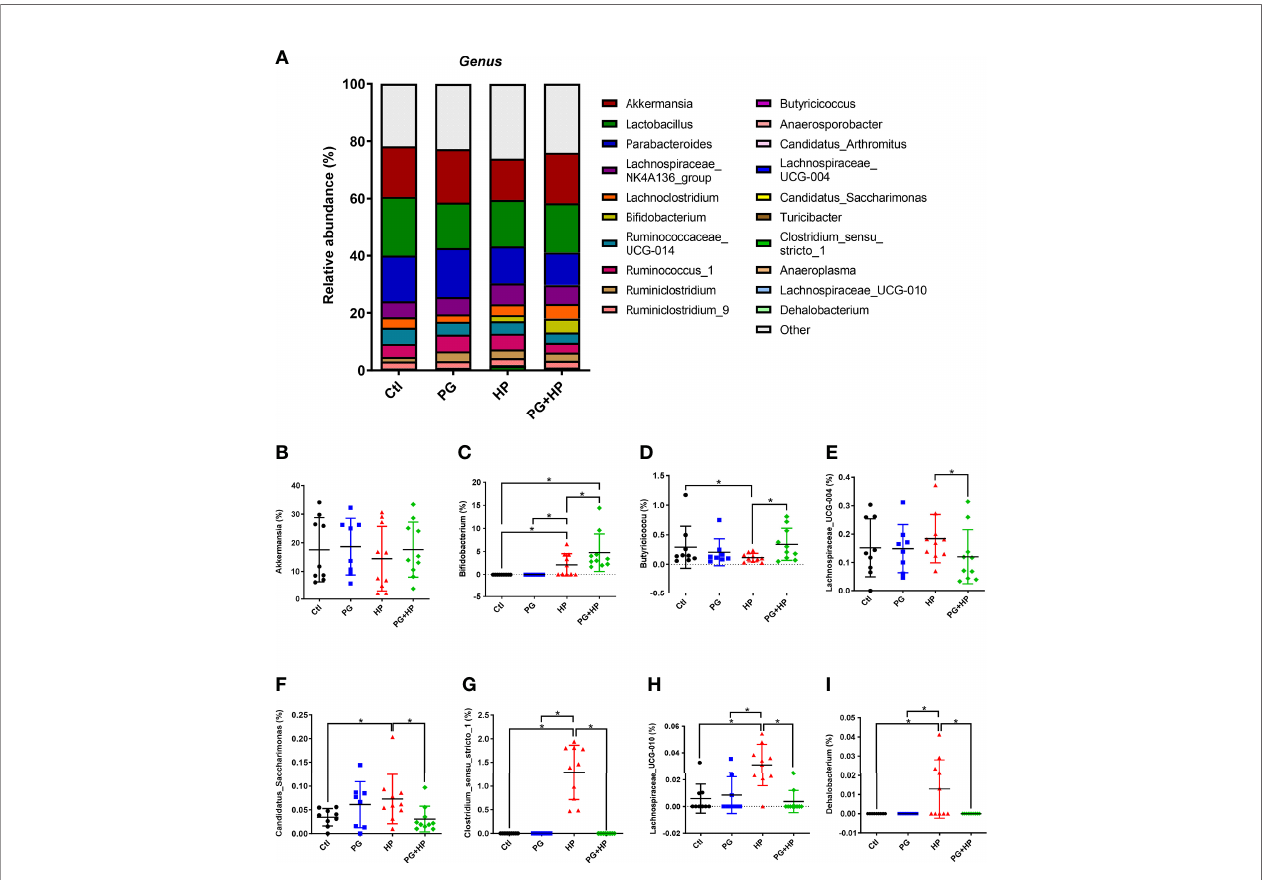
FIGURE 4 | Relative abundance of the gut microbiota in genera. The bacteria taxonomic pro fi les at genus in the gut microbiota in mice administrated with P. goldsteinii MTS01 and H. pylori . (A) Top twenty most abundant genera among four treated groups were shown. Relative abundance of (B) Akkermansia, (C) Bi fi dobacterium, (D) Butyricicoccus, (E) Lachnospiraceae_ UCG-004 , (F) Candidatus_Saccharimonas, (G) Clostridium_sensu_stricto_1, (H) Lachnospiraceae_UCG- 010, (I) Dehalobacterium in the gut microbiota were analyzed. * P <